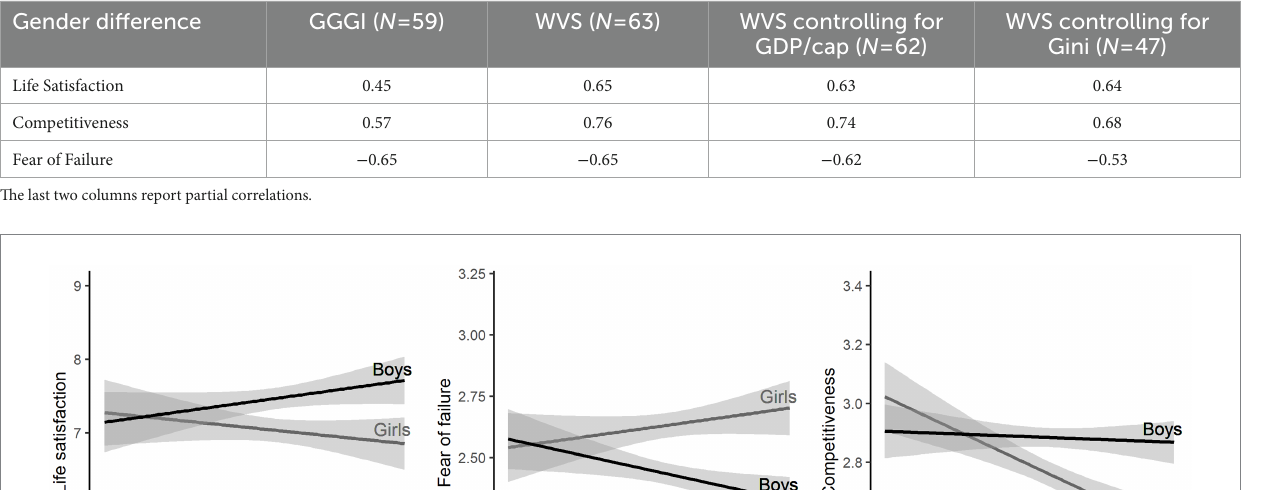
TABLE 2 Pearson and partial correlations between gender differences and measures of gender equality.